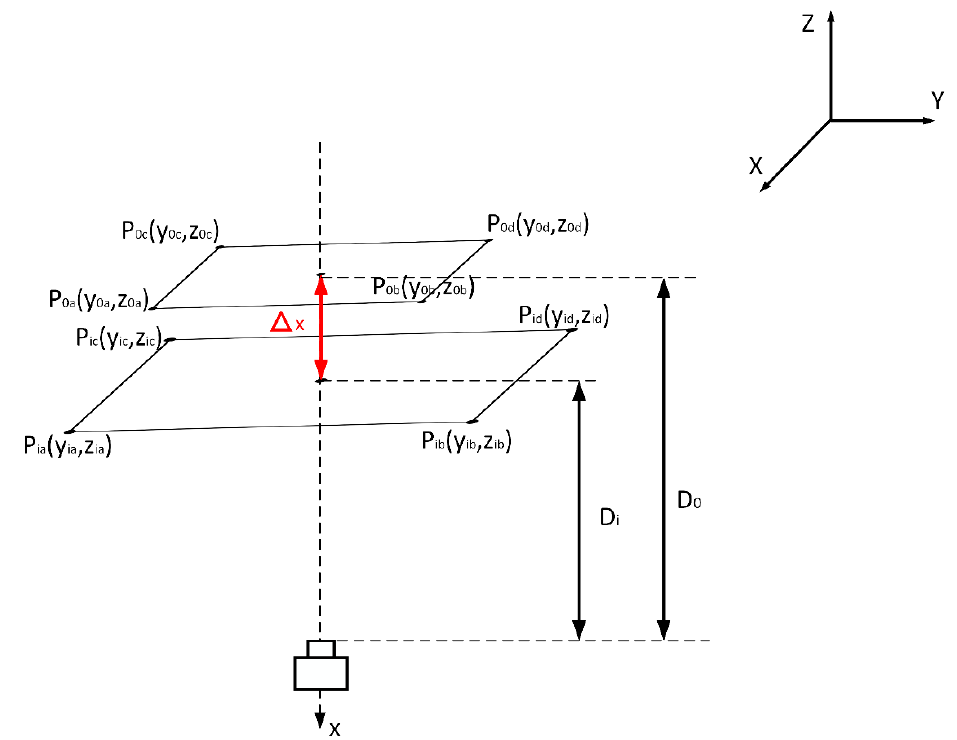
Figure 11. X offset distance.